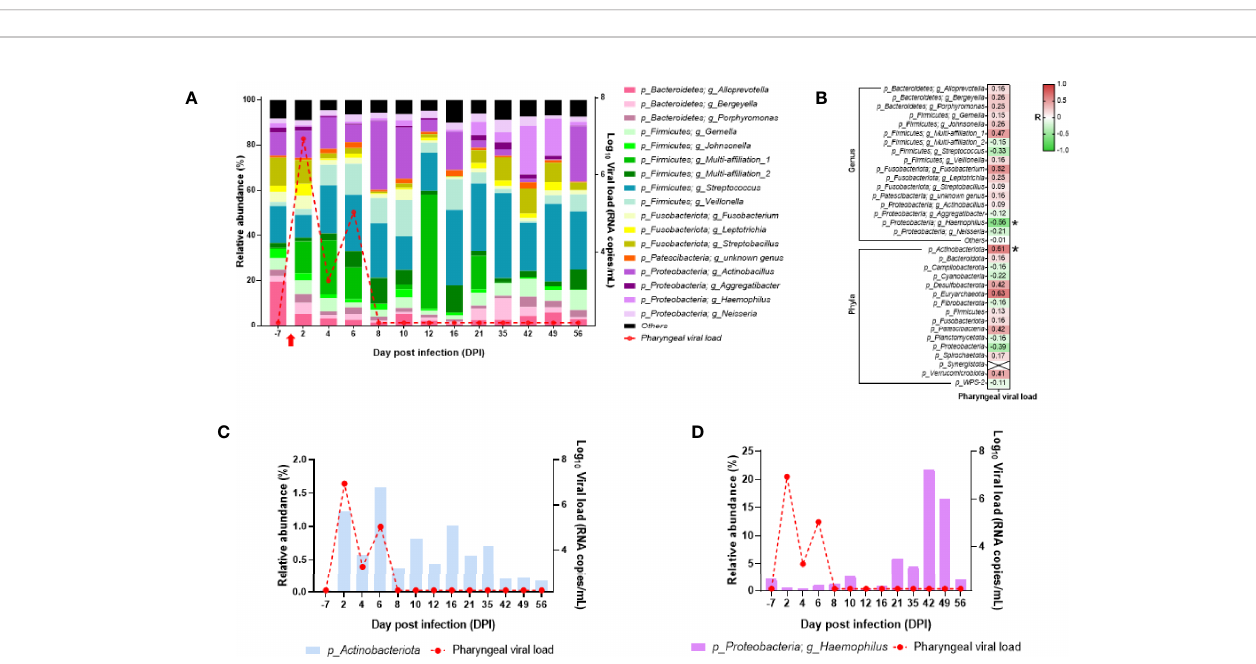
FIGURE 10 | Analyses of the neonate oropharyngeal microbiota composition. (A) Bar plots represent the oropharyngeal microbiota composition. Relative abundance is represented for each time point (left scale). The red curve represents the oropharyngeal viral RNA load (logarithmic scale) of SARS-CoV-2 detected in the neonate over time (right scale). p-Firmicutes and g_Multi-af fi liation_1 correspond to c_Bacilli and p-Firmicutes; g_Multi-af fi liation_2 corresponds to o_Lactobacillales. (B) Spearman correlation analysis between the SARS-CoV-2 oropharyngeal viral RNA load and the oropharyngeal microbiota composition. On the heatmap, the correlation factors of each phylum or genus are represented according to the oropharyngeal viral RNA load. Correlation factors are indicated on a red to green scale. * p < 0.036. (C) Actinobacteria (phylum) relative abundance (left scale) overlapped with oropharyngeal viral RNA load on the logarithmic scale (right scale). (D) Haemophilus (genus) relative abundance (left scale) overlapped with oropharyngeal viral RNA load on the logarithmic scale (right